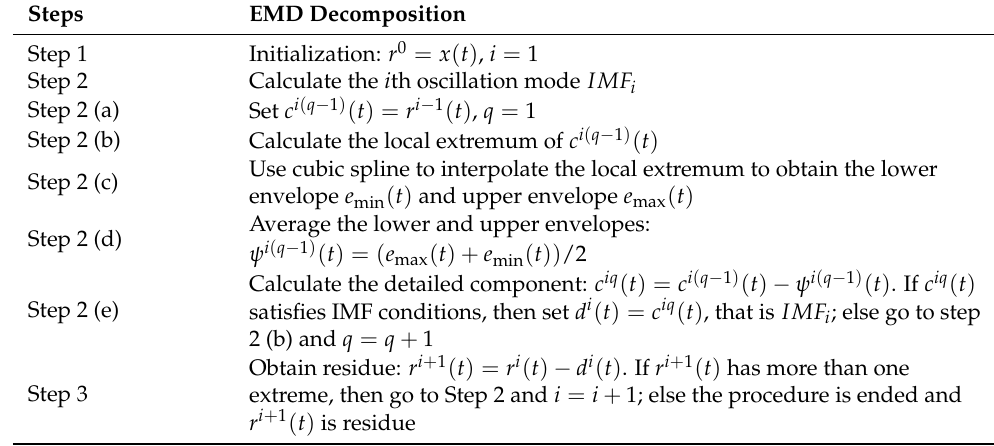
Table 1. The steps of EMD algorithm.